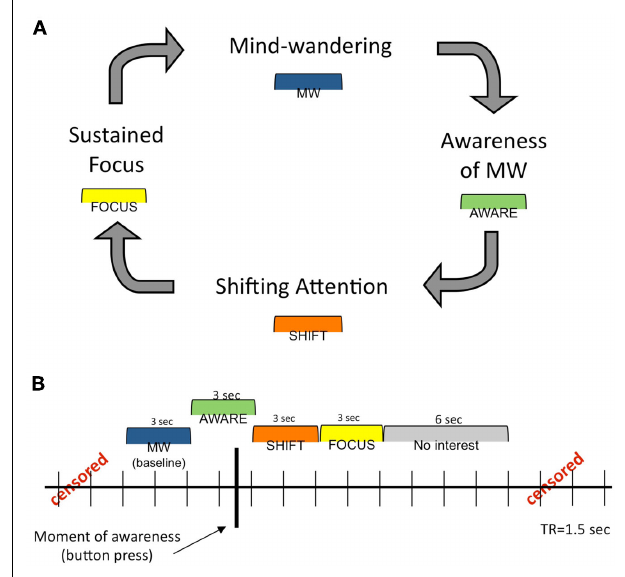
FIGUREA1 |Theoretical and analytical models of FA meditation. (A) Theoretical model of dynamic cognitive states experienced during a session of FA meditation. A detailed description of this cognitive cycle is presented in the Introduction. (B) Analytical model for construction of phases surrounding each button press (represented by the heavy black vertical line). See Materials and Methods for more detailed information.This figure was adapted from a previous publication (Hasenkamp et al.,